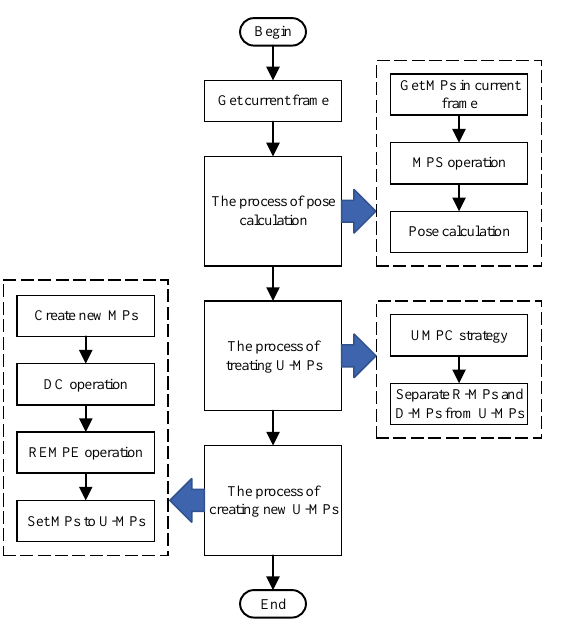
Figure 6. The workflow of the proposed map points treatment in the proposed